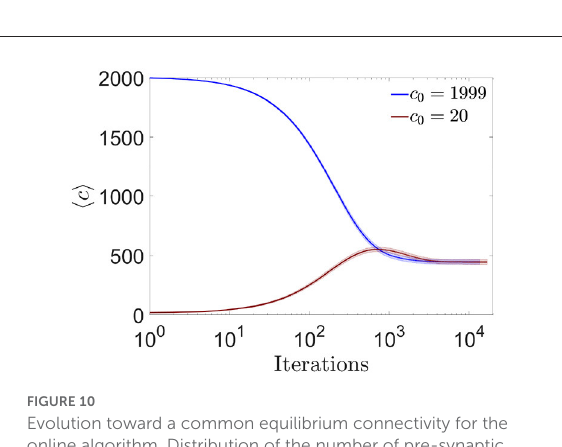
FIGURE10 Evolution toward a common equilibrium connectivity for the online algorithm. Distribution of the number of pre-synaptic connections per neuron across iterations of the online algorithm, for networks with N = 2,000, fully connected (blue) or highly diluted (brown) initial connectivity (mean ± s.d). During one iteration, 10 random changes in pre-synaptic connectivity were evaluated (one at a time) for each neuron (i.e., the complete loop over all neurons, for i = 1:N , in Algorithm 1). Each curve corresponds to one simulation